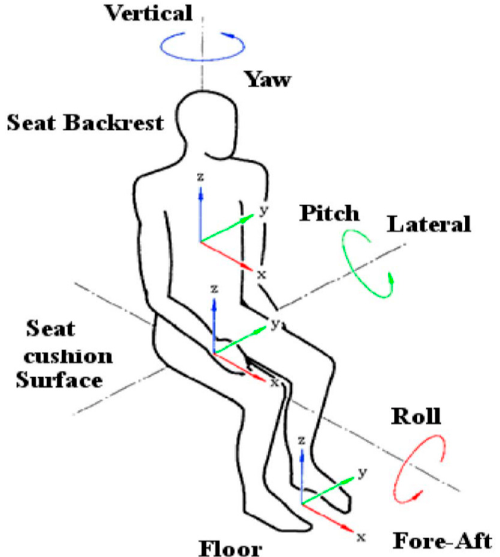
Figure 2. Whole body vibration (WBV) of the human body [9].